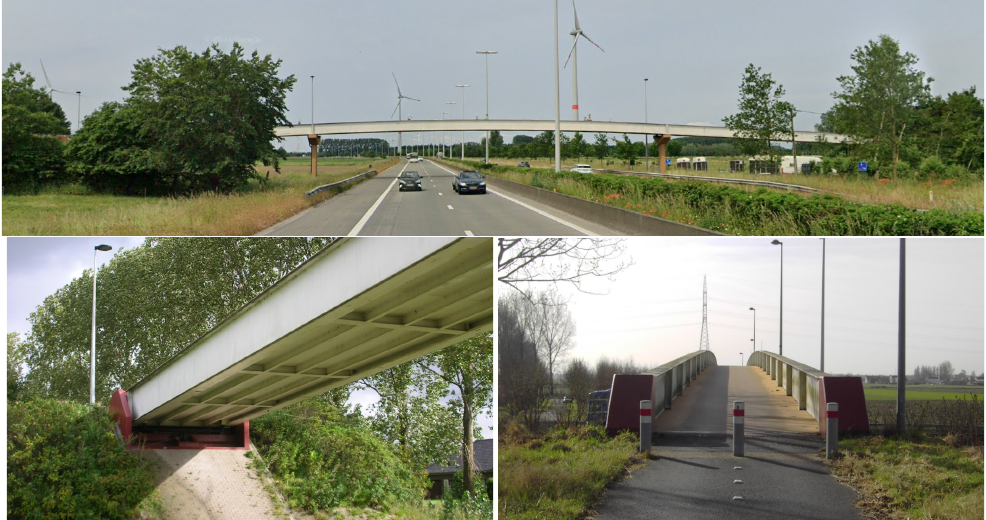
Figure 10. Eeklo